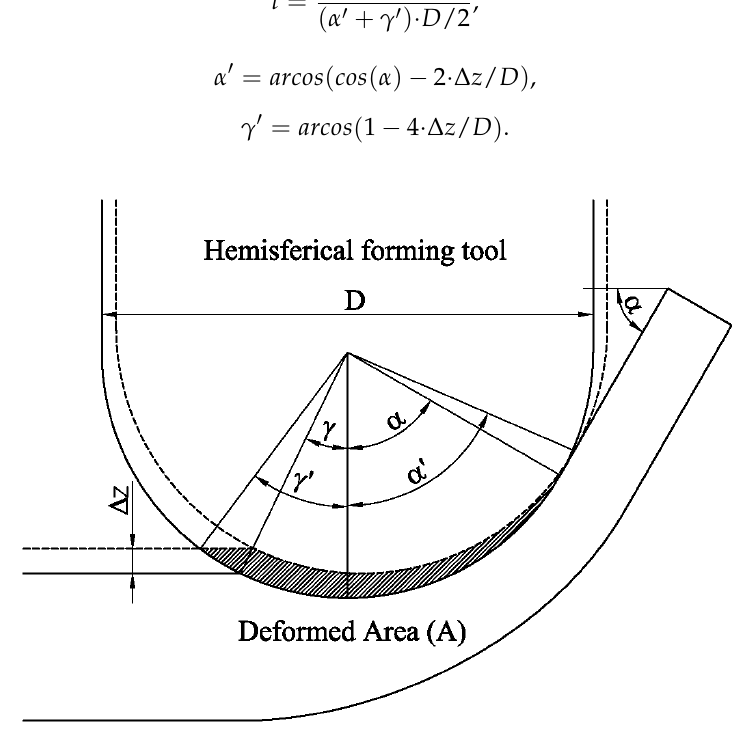
Figure 2. Deformed area defined.